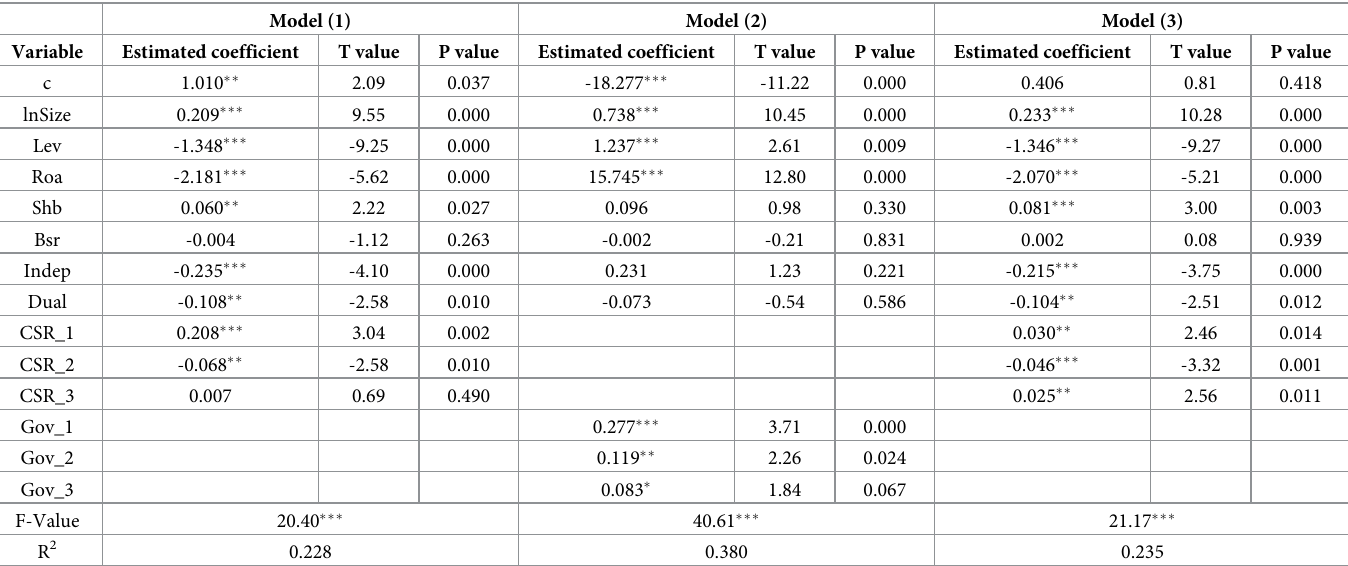
Table 3. Parameter estimation results of dual-threshold